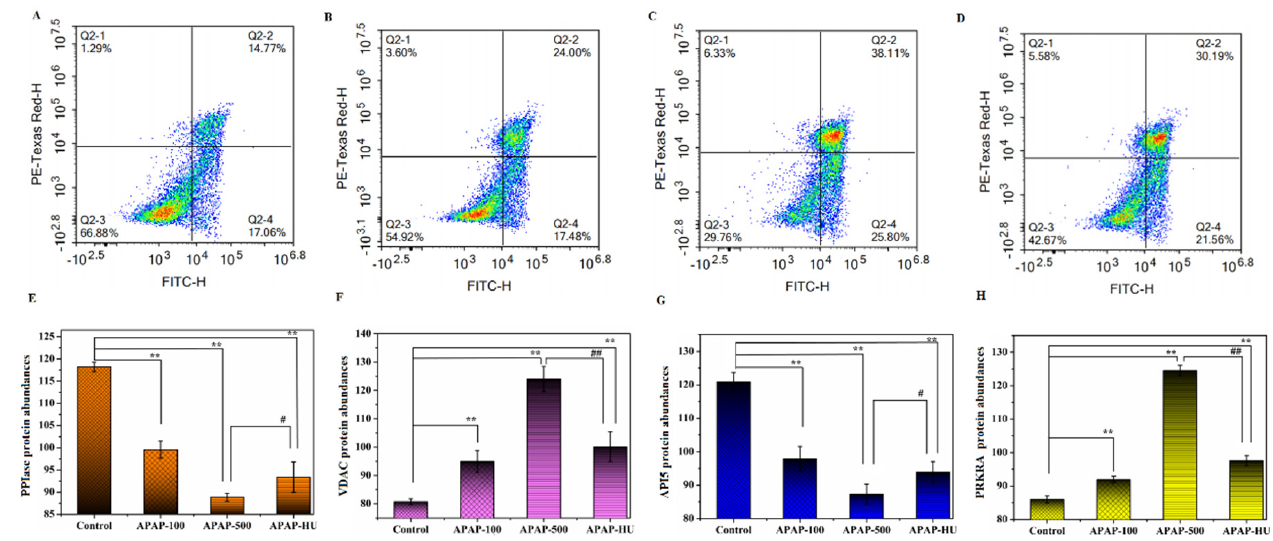
Figure 3. Acetaminophen (APAP) induces apoptosis and participates in the regulation of apoptotic protein expression in cells. ( A ) 50 µ g/mL APAP group, ( B ) 100 µ g/mL APAP group, ( C ) 500 µ g/mL APAP group, and ( D ) 500 µ g/mL APAP + 5 µ g/mL polydatin group. ( E ) Differentially expressed proteins of peptidyl-prolyl cis-trans isomerase (PPIase). ( F ) Differentially expressed proteins of voltage-dependent anion-selective channel protein (VDAC). ( G ) Differentially expressed proteins of apoptosis inhibitor 5 protein (API5). ( H ) Differentially expressed proteins of interferon-inducible double-stranded RNA-dependent protein kinase activator A (PRKRA) in the control group vs. APAP100 vs. APAP500 vs. APAP500-HU. (** p < 0.01 vs. Control; # p < 0.05 vs. APAP-500; ## p < 0.01 vs.